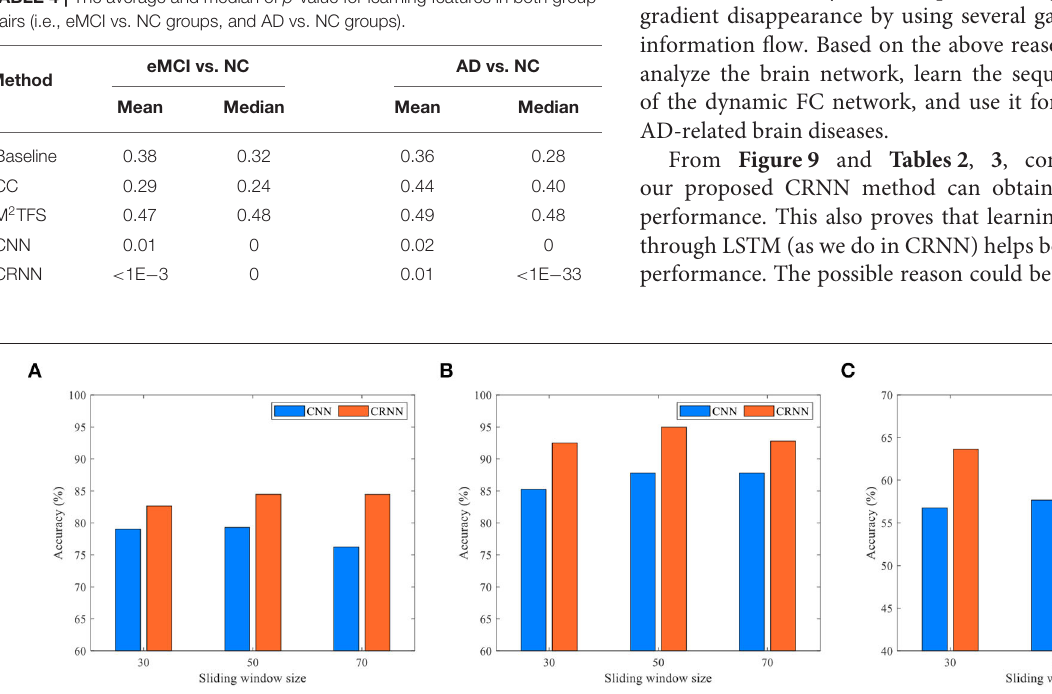
Frontiers in Neuroscience |